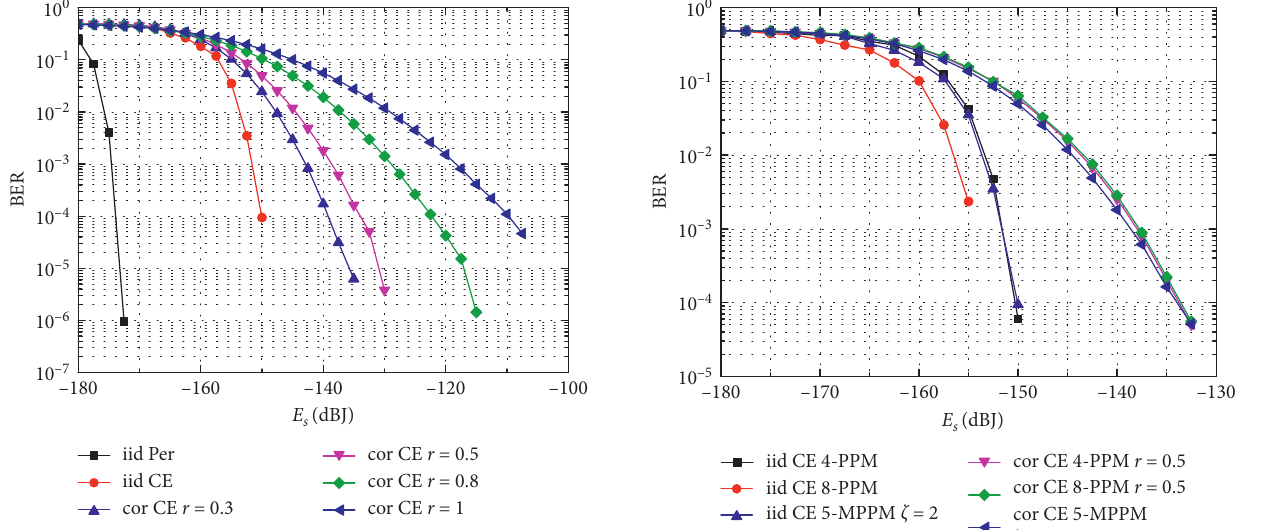
Figure 4: BER of different correlation coefficients in a 2 × 2 MIMO system.